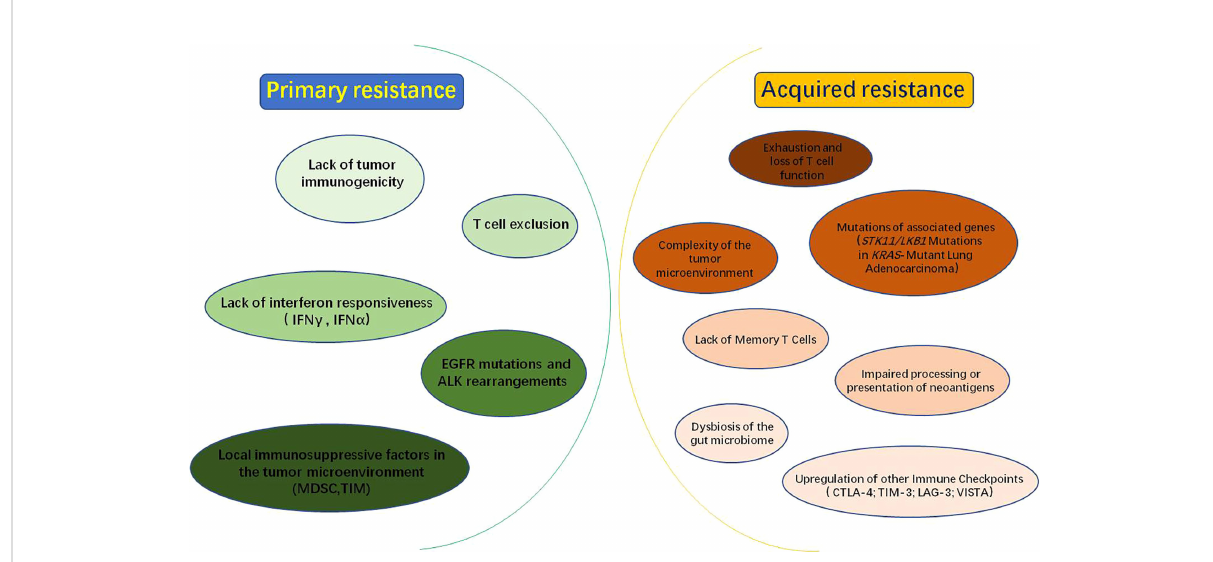
FIGURE 2 Mechanisms of PD-1/PD-L1 inhibitors resistance: PD-1/PD-L1 inhibitor resistance is divided into primary resistance and acquired resistance. Mechanisms of primary resistance include lack of tumor immunogenicity; T-cell rejection; lack of interferon responsiveness, such as IFN g (interferon Gamma) and IFN a (interferon alpha); EGFR (epidermal growth factor receptor) mutations and ALK (anaplastic lymphoma kinase) rearrangements; local immunosuppressive factors within the tumor microenvironment, such as MDSC (myeloid-derived suppressor cell) and TIM (tumor-in fi ltrating myeloid cell). While, the mechanisms of acquired resistance may be related to the following factors: exhaustion and loss of T cell function; impaired processing or presentation of neoantigens; complexity of the tumor microenvironment; mutations in associated genes, such as STK11/LKB1; dysbiosis of the gut microbiome; lack of Memory T Cells and upregulation of other Immune Checkpoints, such as CTLA-4(cytotoxic T-lymphocyte antigen-4), TIM-3(T cell immunoglobulin and mucin domain-containing molecule-3), LAG-3(lymphocyte activation gene-3) and VISTA(V-domain Ig suppressor of T cell